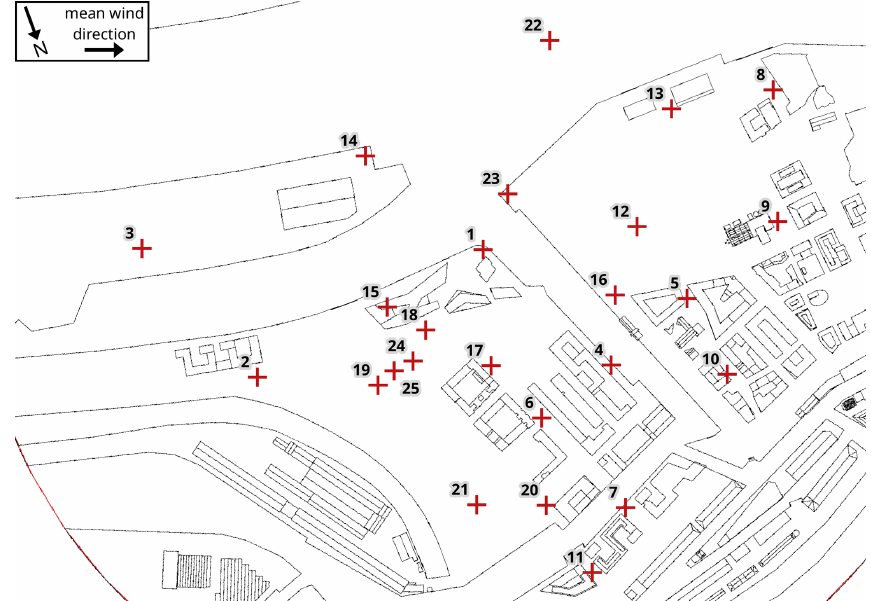
Figure 3. Building layout used in the wind-tunnel experiment. Measurement locations are marked and labelled by their respective number.